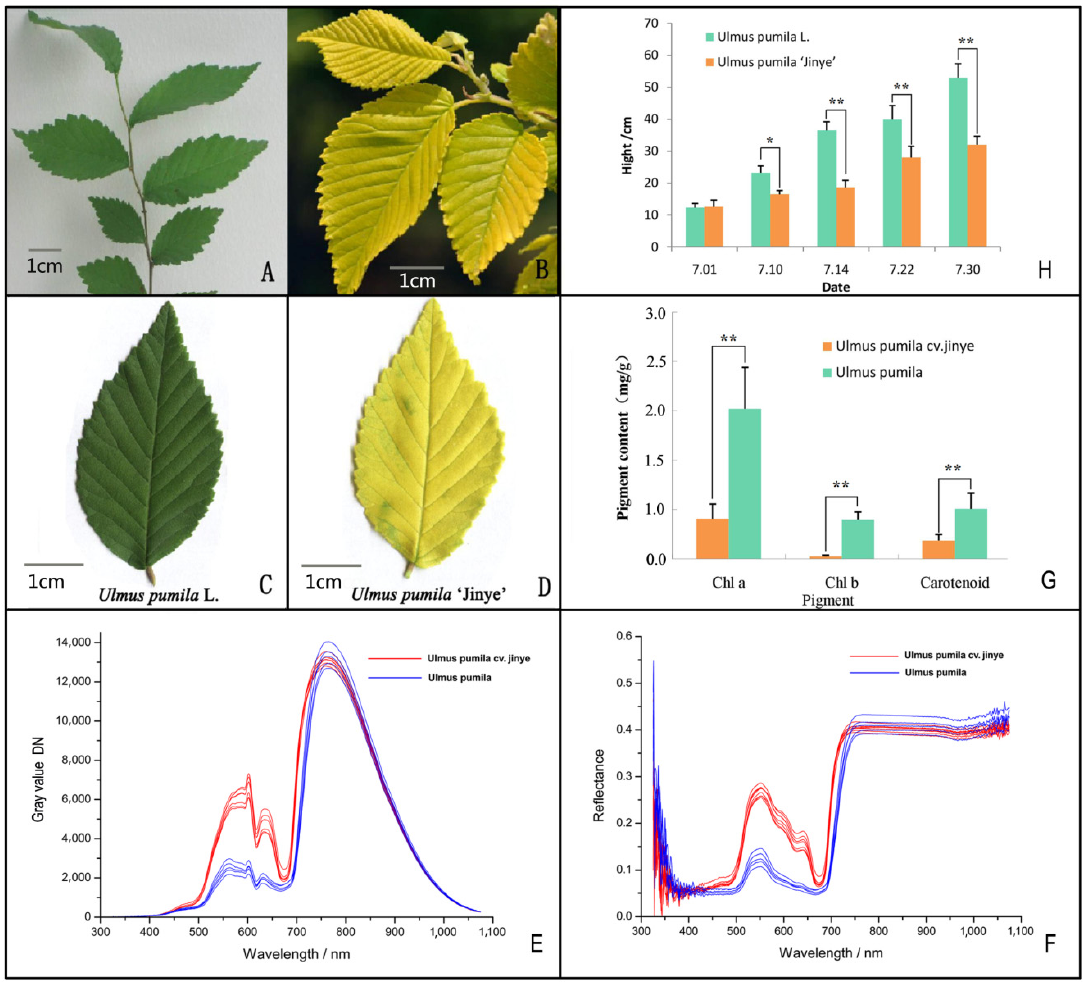
Figure 1. Phenotypic and physiological differences. ( A ) Branches of Ulmus pumila L.; ( B ) Branches of U . pumila ’Jinye’; ( C ) Leaves of U . pumila L.; ( D ) Leaves of U . pumila ‘Jinye’; ( E ) Gray value (digital number) of different elm leaves; ( F ) Spectral reflectance of different elm leaves; ( G ) Pigment content of different elm leaves; ( H ) Height growth of different elms. * mean significant difference ( p < 0.05), ** mean very significant difference ( p < 0.01).